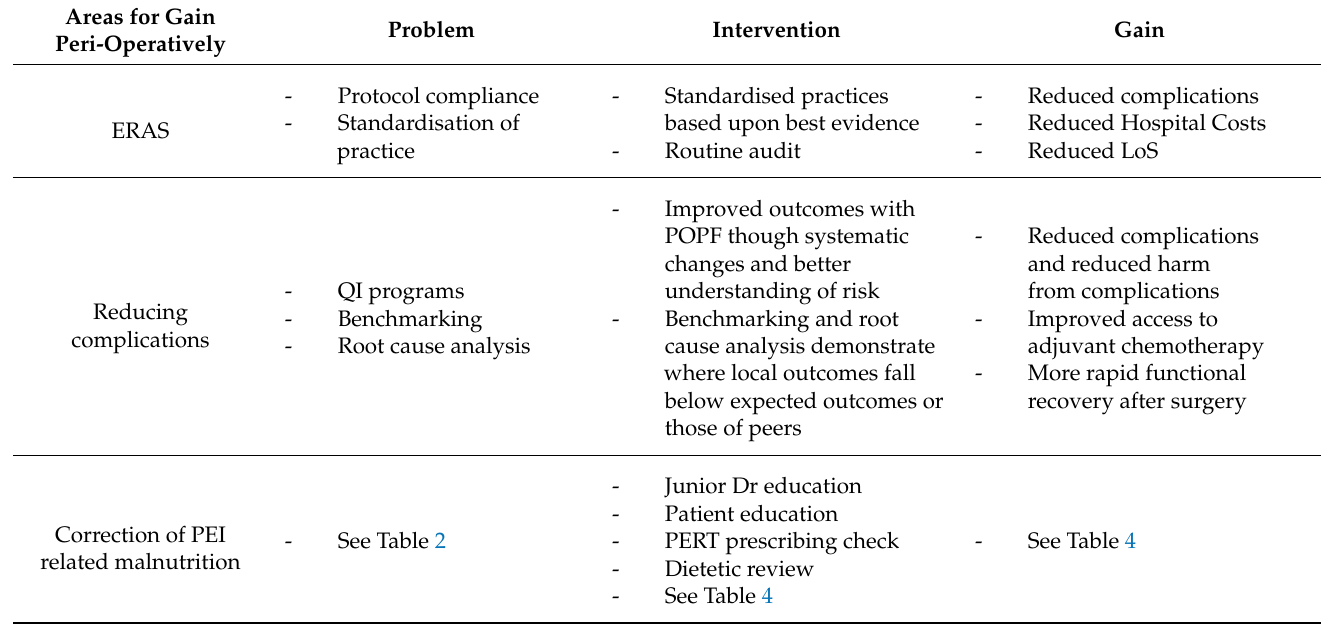
Table 5. Summary of Peri-operative areas for